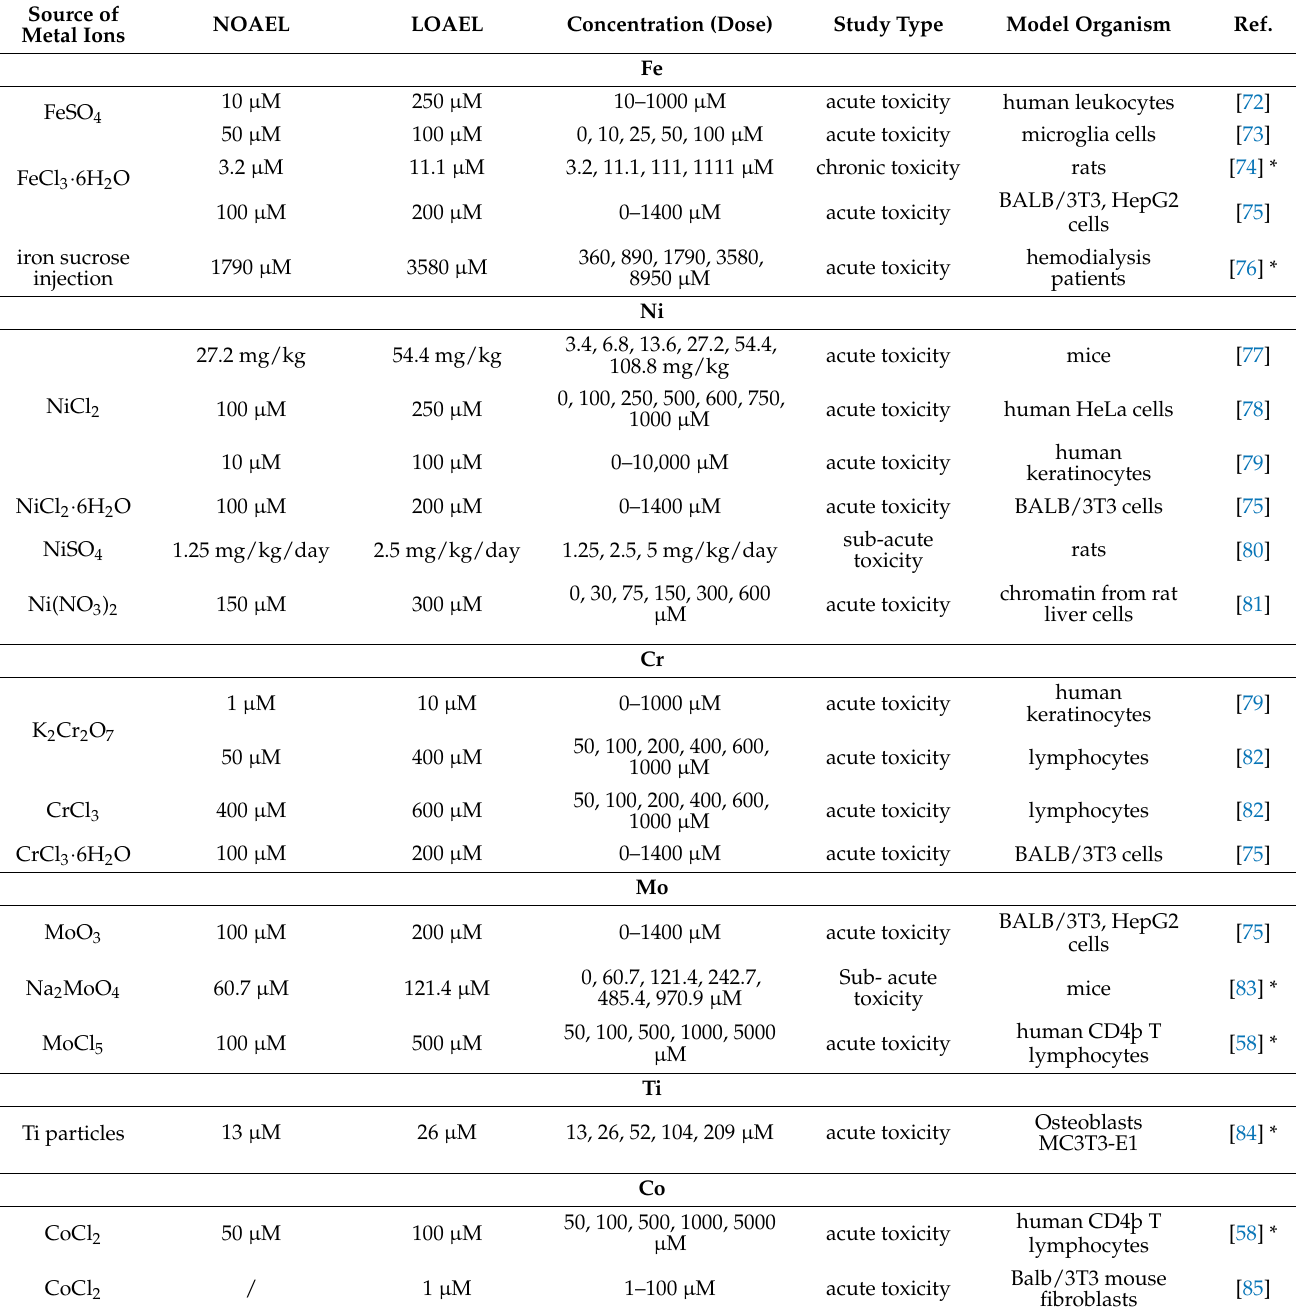
Table 1. NOAEL *, LOAEL * values, tested concentration range, type of study (chronic vs. acute) and model organism tested to determine the toxicity of specific metal